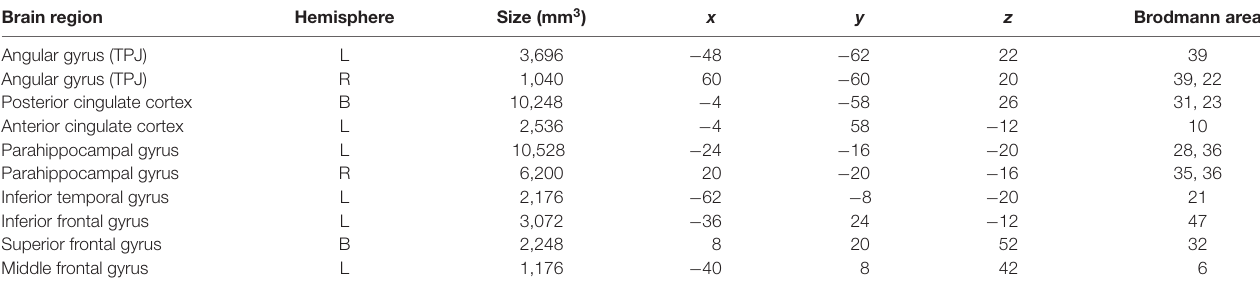
TABLE 1 | Results from episodic autobiographical memory (EAM) meta-analysis. Brain region Hemisphere Angular gyrus (TPJ)